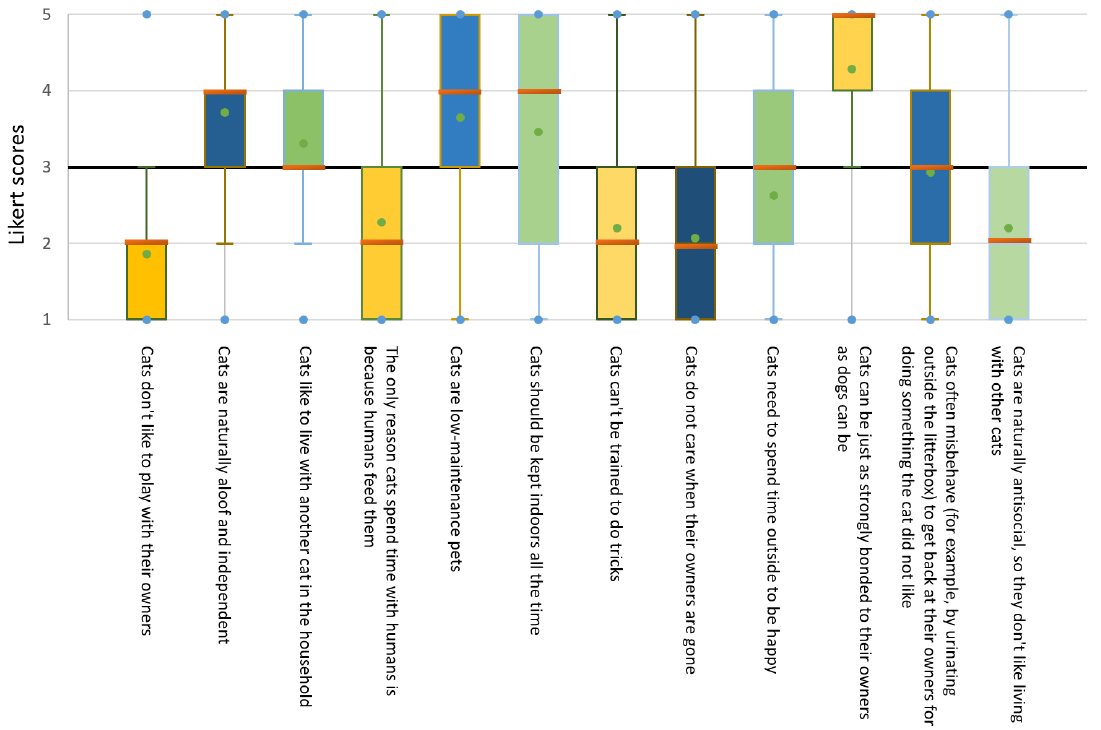
Figure 1. Box plot showing responses by owners to Likert-scale questions about their attitudes to pet cats in general. Response options ranged from 1 (“Strongly Disagree”) to 5 (“Strongly Agree”). Median is indicated by the orange horizontal bar (e.g., at 2 for “Cats don’t like to play with their owners”), upper and lower boundaries represent 1st and 3rd quartiles, and the green dot represents the mean. The midline at Likert score = 3 represents a neutral view, “Neither Agree nor Disagree”; size of box indicates degree of variability among responses, and box position relative to this line indicates where most respondents’ views fell on these questions. Box colors are to aid in discriminating between adjacent boxes only.